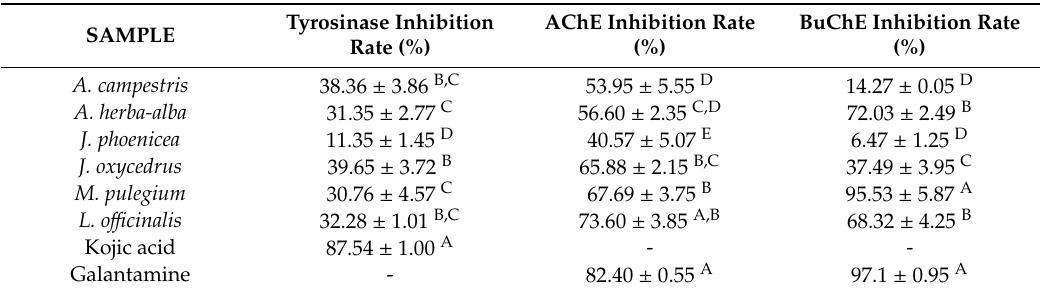
Table 4. Tyrosinase, acetyl and butyl cholinesterase (AChE and BuChE) inhibitory activities of the EOs of the six selected Algerian